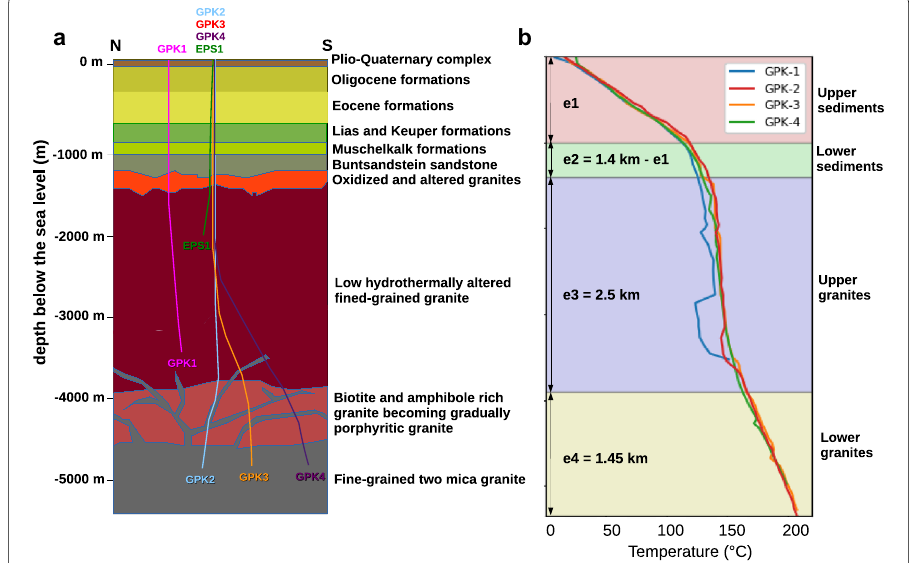
Fig. 3 a 2D conceptual geology at Soultz [modified after Dezayes et al. (2005a, Fig. 28, 2005b) and after Aichholzer et al. (2016, Fig. 3)]. Trajectories of GPK1, EPS1, GPK2, GPK3 and GPK4 wells are shown with colored lines. b Temperature–depth profiles after drilling operations superimposed to the simplified reservoir model with four main geological units (Cuenot et al. 2008). Here, e 1 , e 2 , e 3 and e 4 correspond to the unit thicknesses,